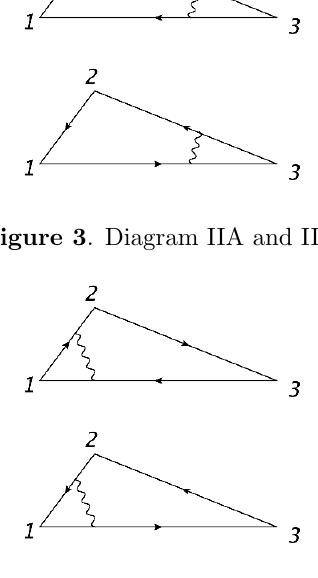
Figure 4 . Diagram IIIA and